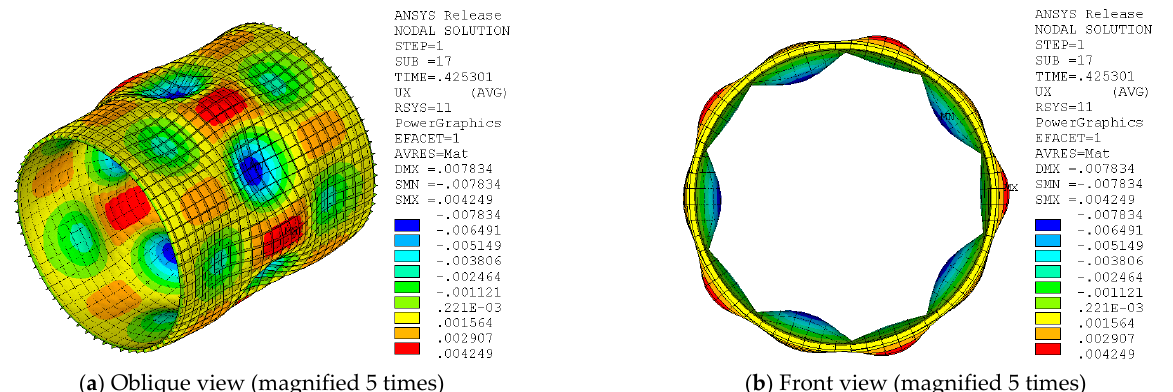
Figure 7. Radial displacement contour map at the critical point of the post-buckling path for the model of the stiffened cylinders with L / R = 2.51 and the SS3 boundary condition when the material is brass and ξ = 0.05.